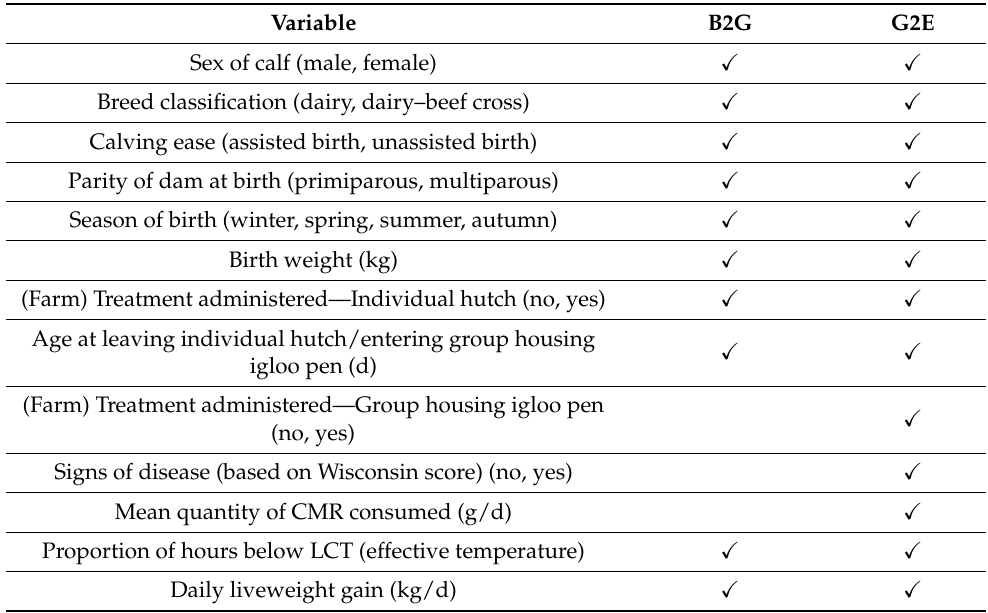
Mean quantity of CMR consumed (g/d) Proportion of hours below LCT (effective